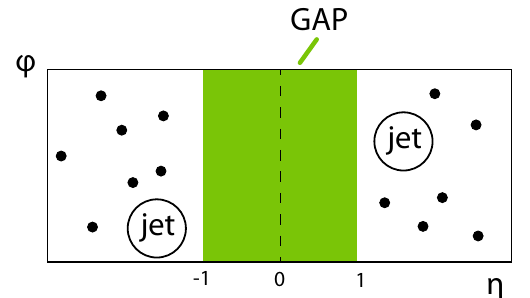
Fig. 2 Schematic picture of a jet-gap-jet event in the ϕ vs. η plane. The circles indicate the two jets reconstructed on each side of the detector, while the dots represent the remaining hadronic activity in the event. The shaded area corresponds to the region of the potential rapidity gap, in which the charged-particle multiplicity is measured (the so-called gap